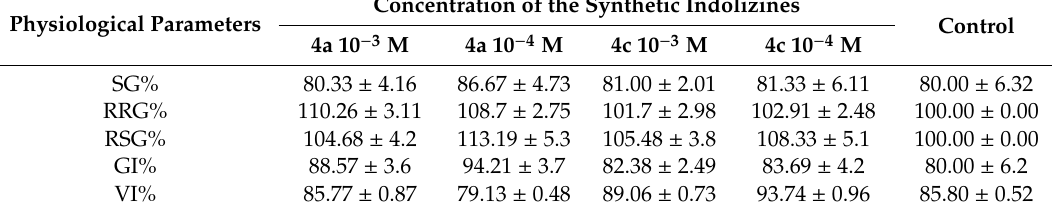
Table 1. Evaluation of the impact on the seed germination of Triticum estivum L. exposed to di ff erent concentrations of indolizine compounds. The results represent the mean values ± standard deviation of four replicates. Concentration of the Synthetic Indolizines Physiological Parameters